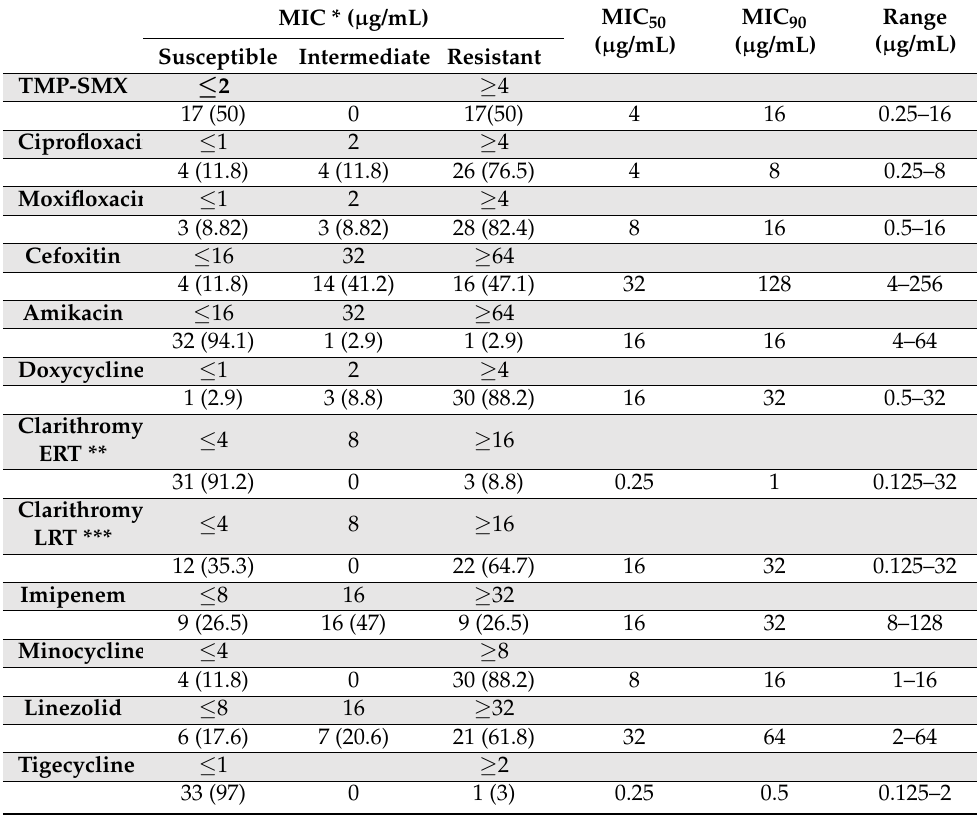
Table 2. In vitro antimicrobial susceptibility of 34 Mycobacterium abscessus complex